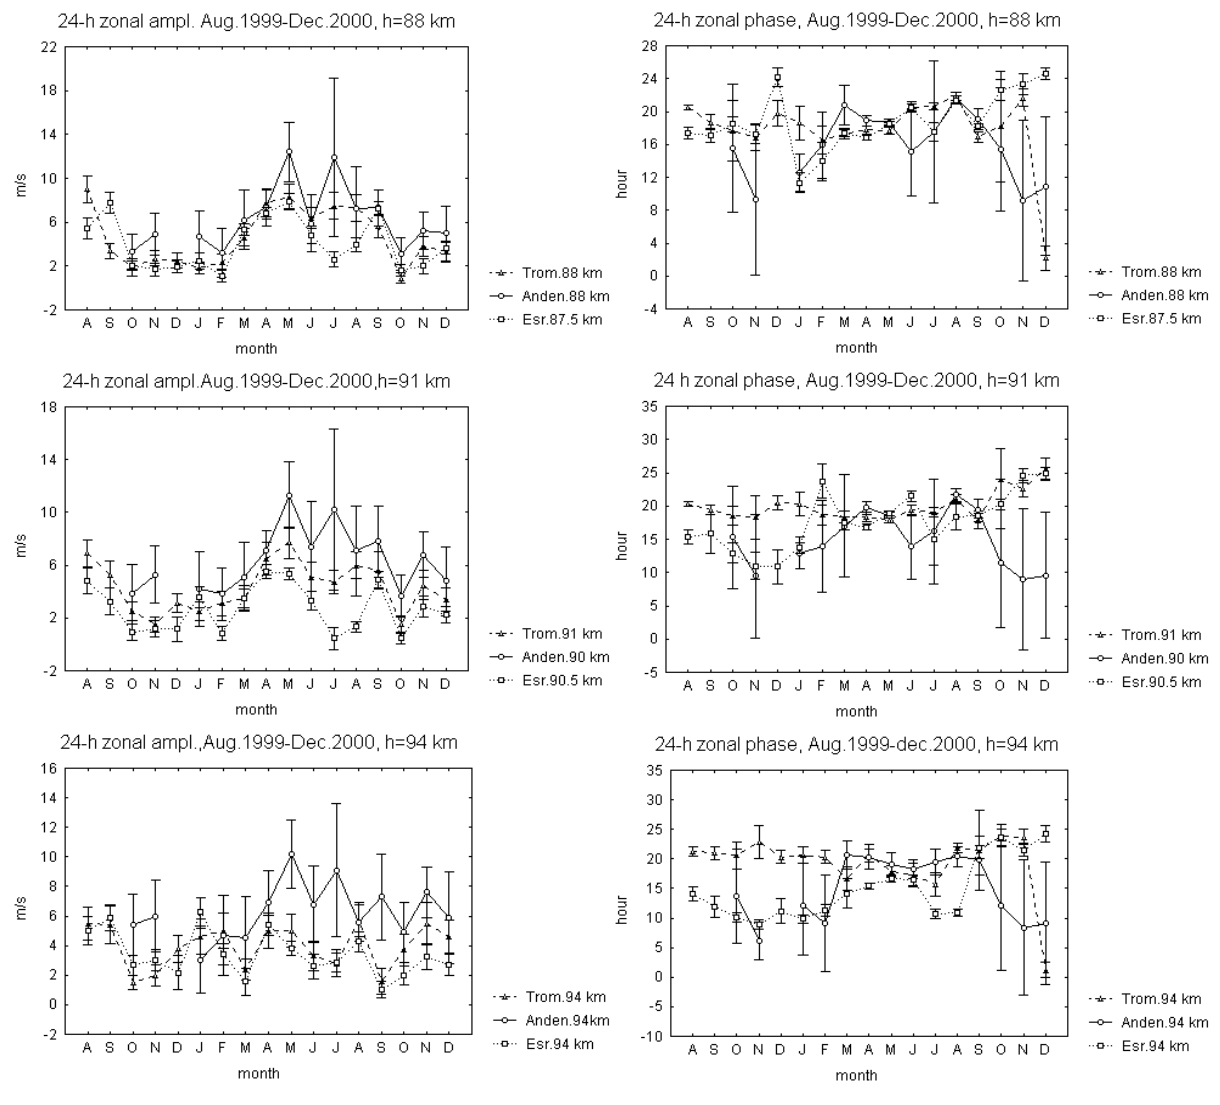
Fig. 3. ( a ) Monthly mean amplitudes of zonal component of the diurnal tide measured at “Scandinavian triangle”. ( b ) Monthly mean phases of zonal component of the diurnal tide measured at “Scandinavian